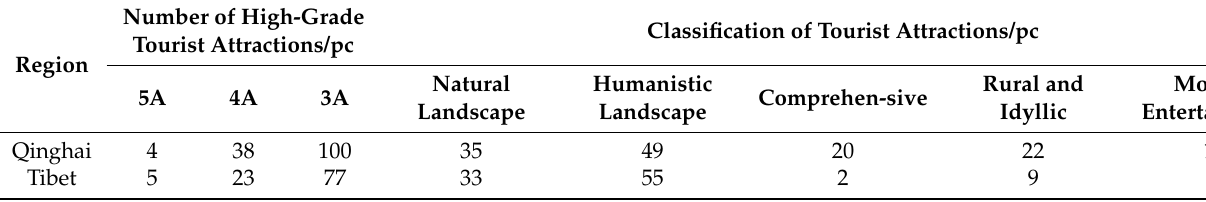
Table 1. High-grade tourist attractions on the Tibetan